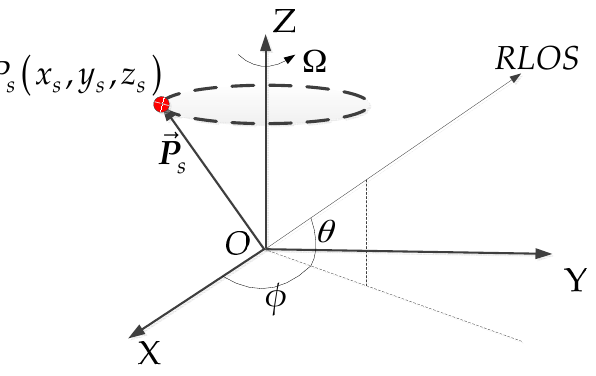
Figure 1. 3D imaging geometry of a spinning target.